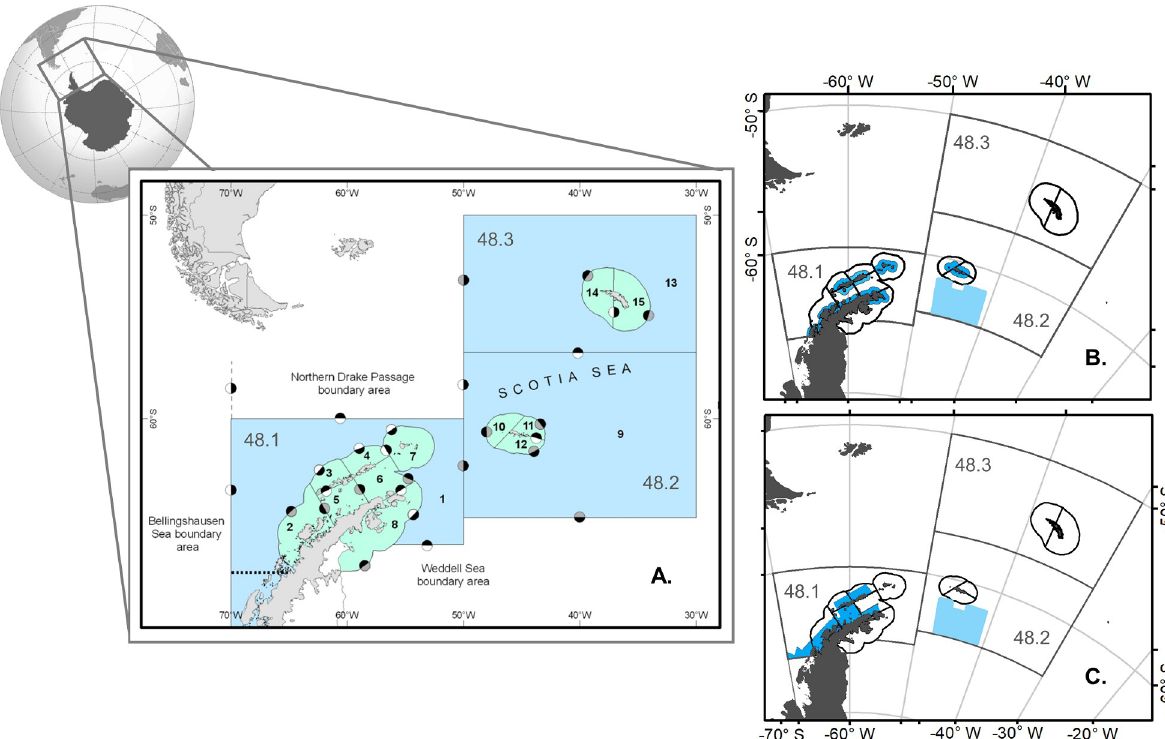
Fig 1. Spatial structure of the ecosystem model (A) and the two MPA scenarios (B-C). The ecosystem model arena (A) is comprised of 15 SSMUs (labeled in black) within three Subareas (labeled in grey) (Subarea 48.1 includes eight SSMUs, Subarea 48.2. four SSMUs, and Subarea 48.3 three SSMUs). The modeled MPA scenarios are simplified representations of (B) the initial MPA proposed to CCAMLR by the Delegations of Argentina and Chile (the D1MPA scenario) in 2017 [54], and (C) a scenario based on U.S. stakeholders’ spatial protection priorities (the US10 scenario). In (B-C), closed areas specific to each scenario are shaded in darker blue, and the existing South Orkney Islands Southern Shelf MPA is in lighter blue.